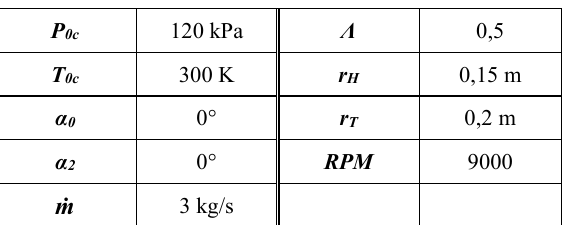
Table 1. Input data.